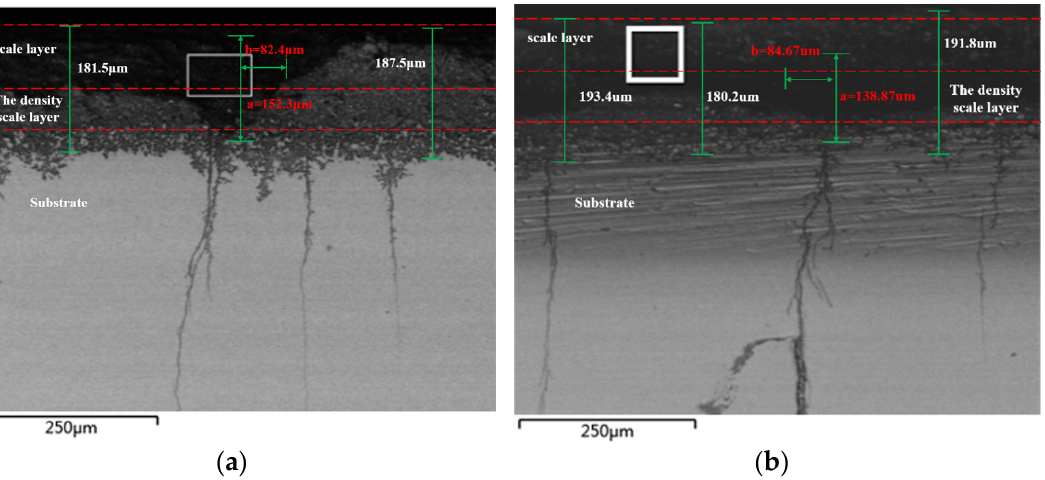
Figure 8. Morphology of Corrosion Pits in Super 13Cr Tubing. ( a ) Morphology of Corrosion Pits When the Pitting Shape Parameter Is 0.243. ( b ) Morphology of Corrosion Pits When the Pitting Shape Parameter Is 0.296.